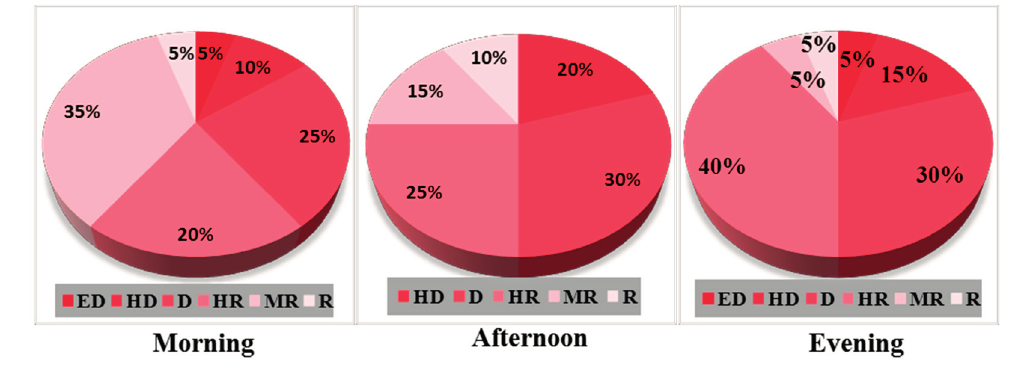
Figure 6. Percentage of noise distribution in